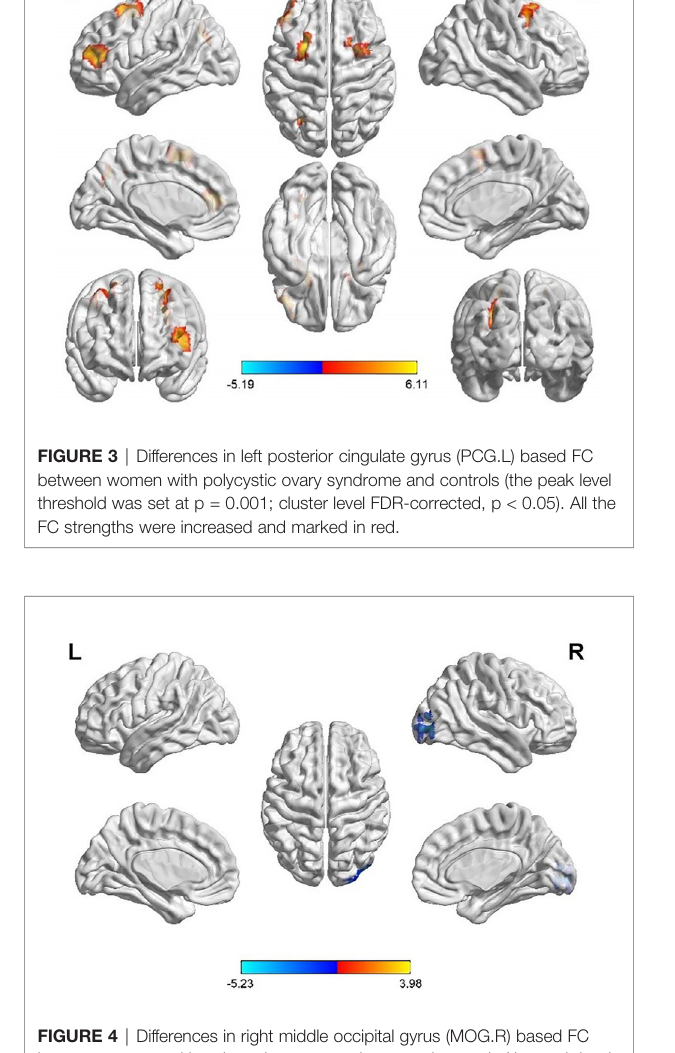
FIGURE 4 | Differences in right middle occipital gyrus (MOG.R) based FC between women with polycystic ovary syndrome and controls (the peak level threshold was set at p = 0.001; cluster level FDR-corrected, p < 0.05). The FC strength was decreased and marked in